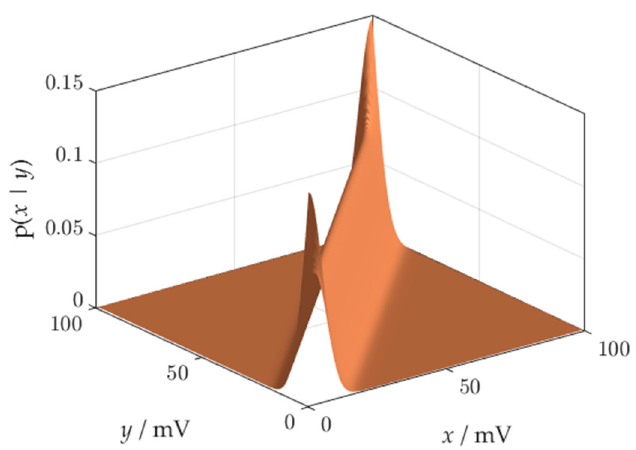
Figure 3. A result of probabilistic inversion.